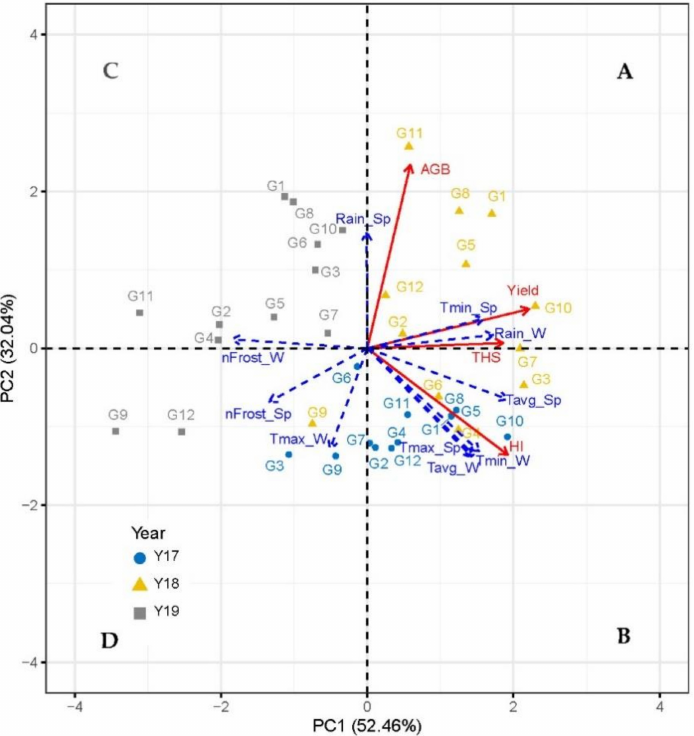
Figure 3. Principal component loading plots and scores of the PC1 and PC2 after PCA on AGB, SY, HI, and THS as a function of growing seasons and accessions. Box-Cox-transformed data was used for the PCA. The square indicates a Pearson correlation coefficient of 1. The red arrows represent the principal variables. Dotted blue arrows represent the supplementary variables (weather parameters). The values from 1 to 12 represent the different accessions (see Table 1 for more details). Tavg_W (average temperature in winter), Tmax_W (maximum temperature in winter), Tmin_W (minimum temperature in winter), Rain_W (rainfall in winter), nFrost_W (number of days per month where the minimum temperature dropped below 0 ◦ C in winter), Tavg_Sp (average temperature in spring), Tmax_Sp (maximum temperature in spring), Tmin_Sp (minimum temperature in spring), Rain_Sp (rainfall in spring), nFrost_Sp (number of days per month where the minimum temperature dropped below 0 ◦ C in spring). A, B, C, D indicate upper-right, lower-right, upper-left, lower-left quadrant,